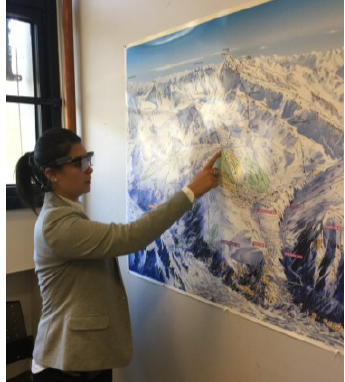
Figure 2. Participant during the eye-tracking experience, wearing Tobii